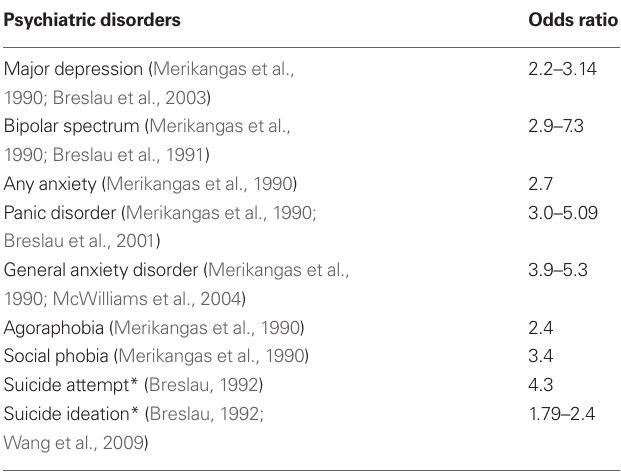
Table 2 | The odds ratios of comorbid psychiatric disorders in patients with